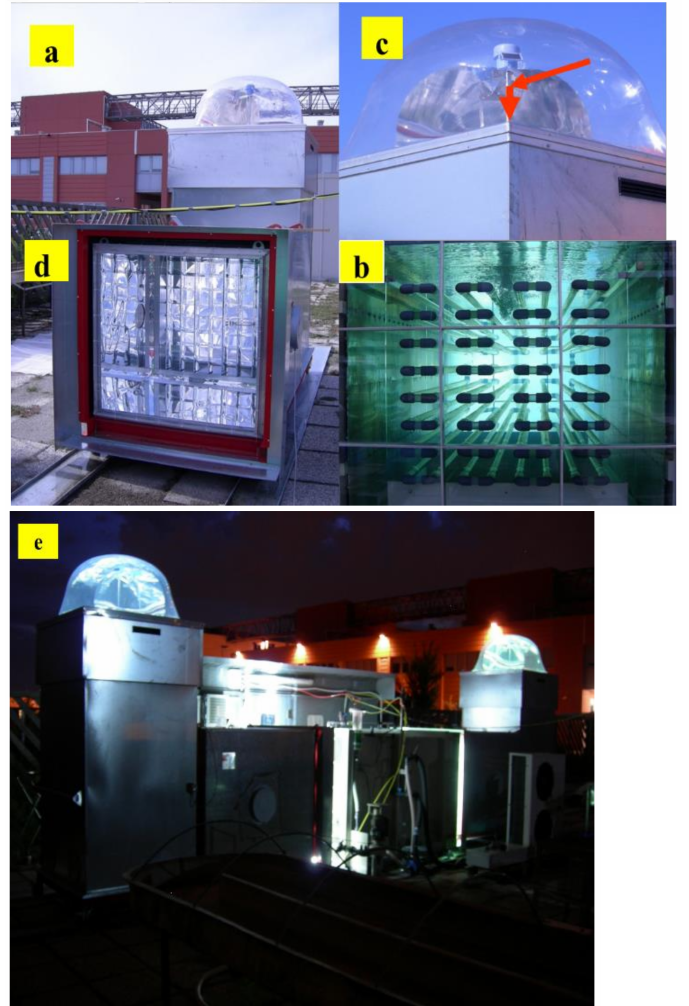
Figure 8. The 110 L photobioreactor utilized for the hydrogen production experiments. ( a ) General view of the photobioreactor; ( b ) frontal view of the photobioreactor; ( c ) sun-tracking mirrors collecting light; ( d ) light ducts delivering light to the photobioreactor from the opposite sides; ( e ) nocturnal view of the photobioreactor with two light bulbs (1000 W each) placed in the light duct to provide illumination to the culture during the